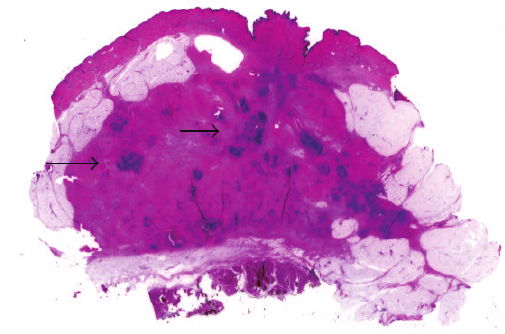
Figure 3: LS performed on a case treated with neoadjuvant chem- otherapy evidence small foci of residual invasive breast carcinoma (arrows).